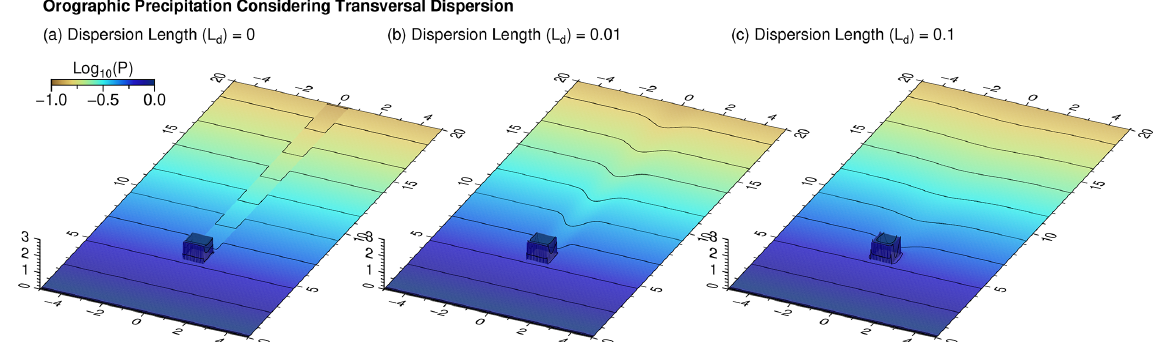
Figure 3. Effect of transversal dispersion on the precipitation behind an